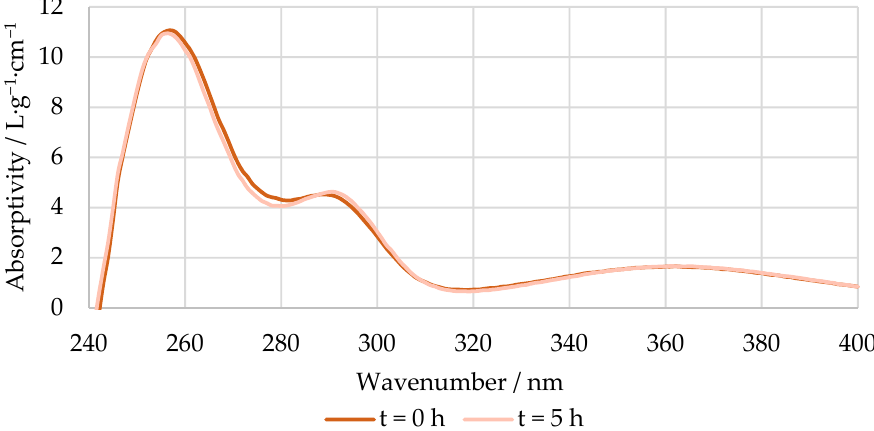
Figure 5. Absorptivity vs. wavenumber of the reaction mixture at pH 12 at the beginning and end of the methylolation of HLS at 50 °C.